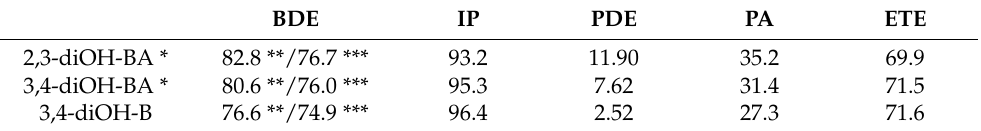
Table 2. Computed thermodynamic descriptors of tested phenols characterizing the radical scaveng- ing activity in the liquid phase (water) at B3LYP/6-31+G(d,p)//B3LYP/6-311++G(2d,2p)